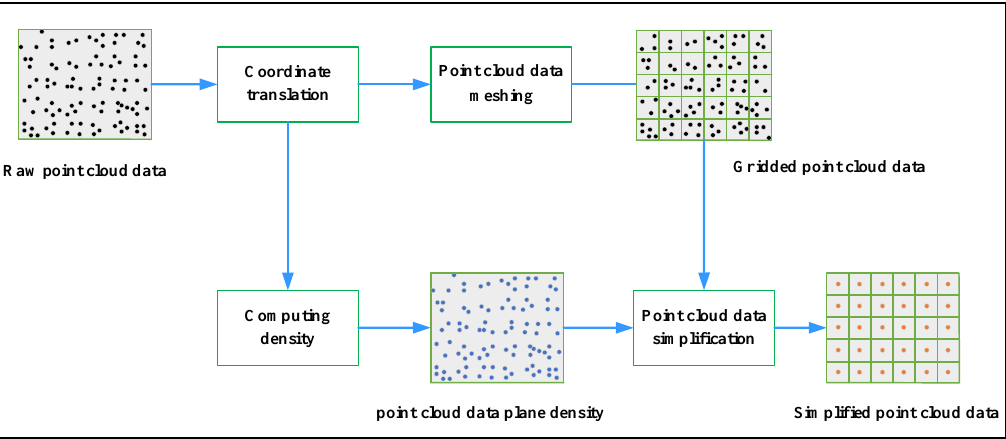
Figure 4. PDS-Algorithm Simplified Process flow chart.